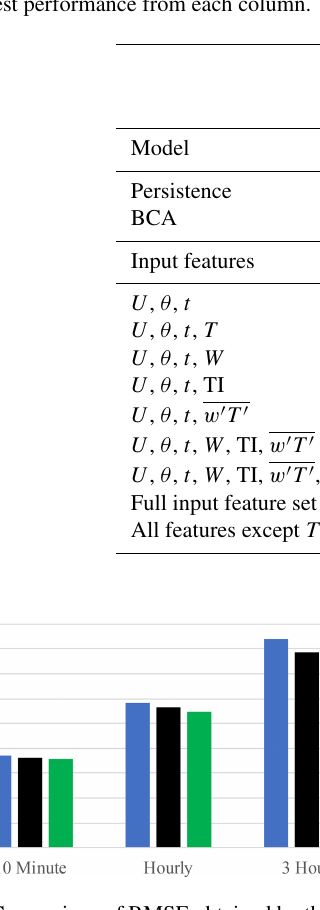
Figure 3. Comparison of RMSE obtained by the persistence, BCA, and ARIMA–RF with the full input feature set for all forecasting